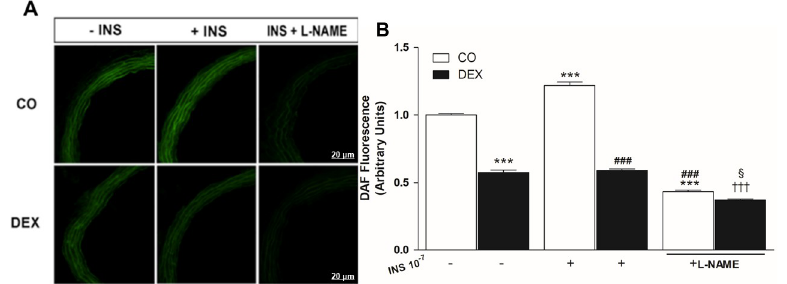
Fig 4. Effects of insulin on nitric oxide (NO) production in the superior mesenteric artery. (A) Representative images of DAF fluorescence, a NO indicator and (B), quantification of DAF fluorescence in a superior mesenteric artery of control (CO) and dexamethasone treated (DEX) rats in the presence and absence of insulin or presence and absence of L-NAME. 20 to 30 slices of each ring of the superior mesenteric artery were analyzed (n = 4 animals). Scale bar = 20 μ m. Values are expressed as mean ± S.E.M. For data analysis, one-way ANOVA followed by Bonferroni post- test was used. ��� p < 0.001, vs CO under basal condition (-); ### p < 0.001 vs CO under INS stimulation (+); ††† p < 0.001 vs DEX under INS stimulation (+); § p < 0.05, vs CO under INS stimulation + L-NAME (+).